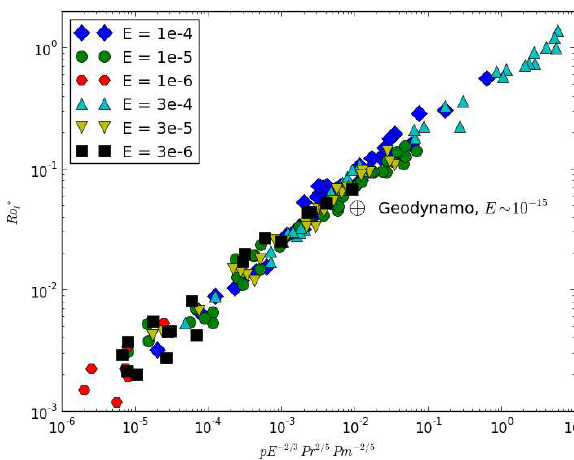
Figure 2. Modified local Rossby number Rol * as a function of the combination pE −2/3 Pr 2/5 Pm −2/5 (implicitly χ ). This figure